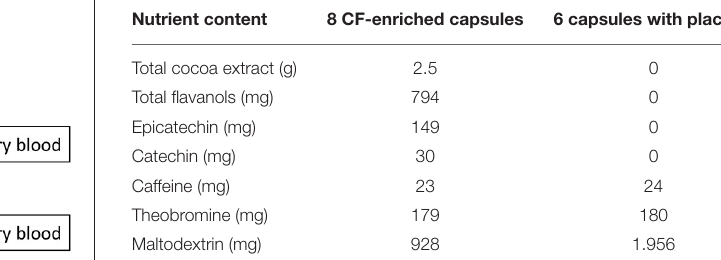
TABLE 4 | Nutrient content of the